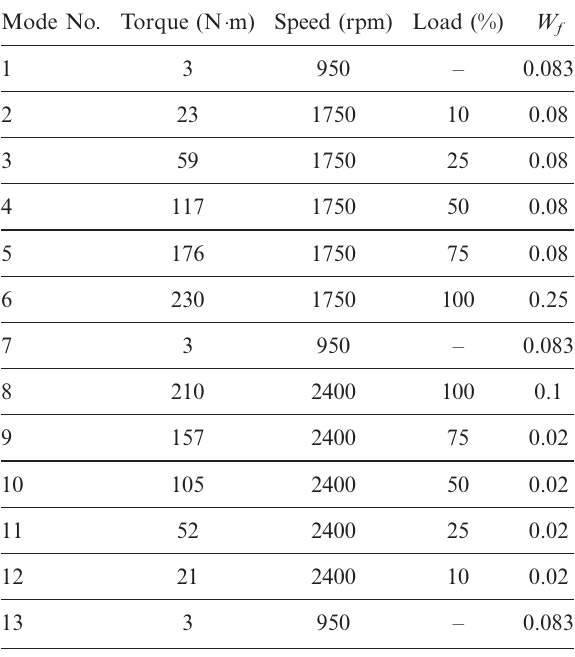
Table 2. ECE-R49 13 points test operating conditions